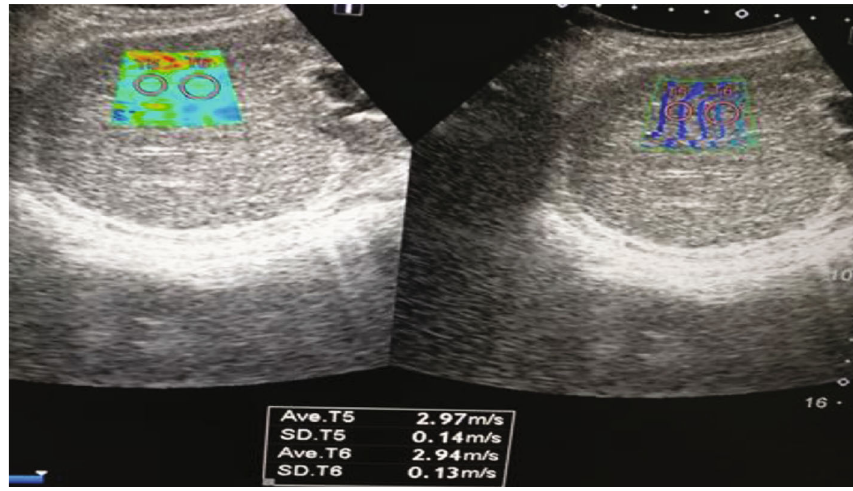
Figure 4: Di ff use hepatic parenchymal disease with F4 METAVIR score expressed as shear wave velocity (2.97